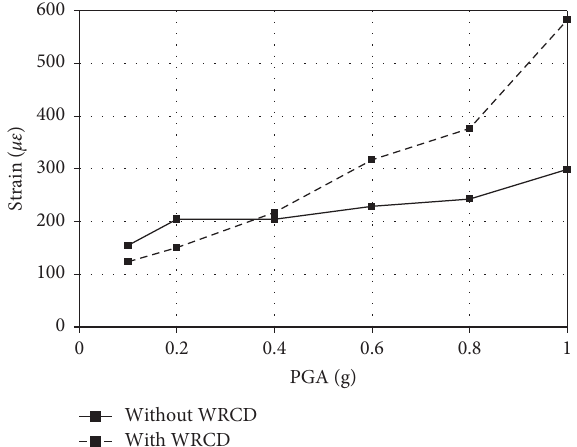
Figure 18: Maximum strain response at 3# sliding bearing pier bottom.